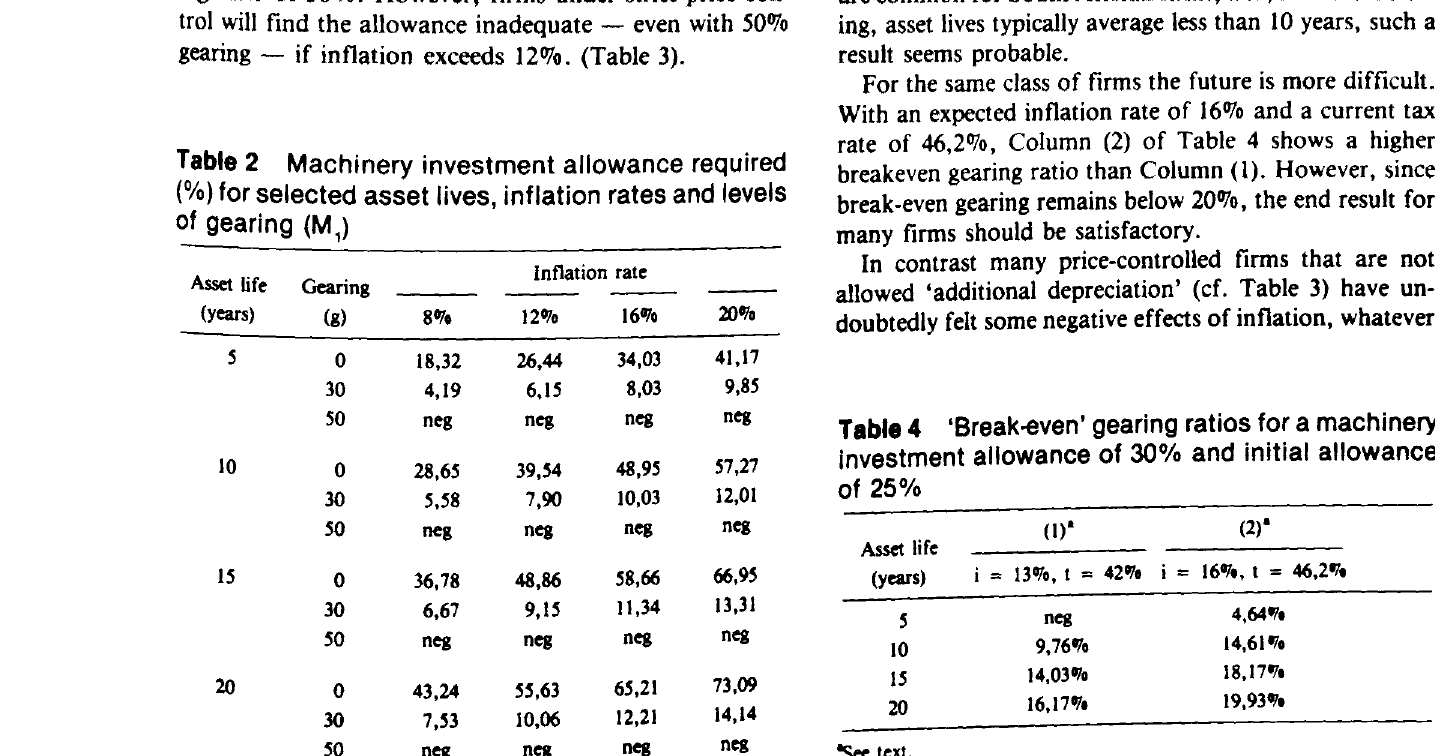
Machinery investment allowance required (%) for selected asset lives, inflation rates and levels of gearing (M 1) Asset life